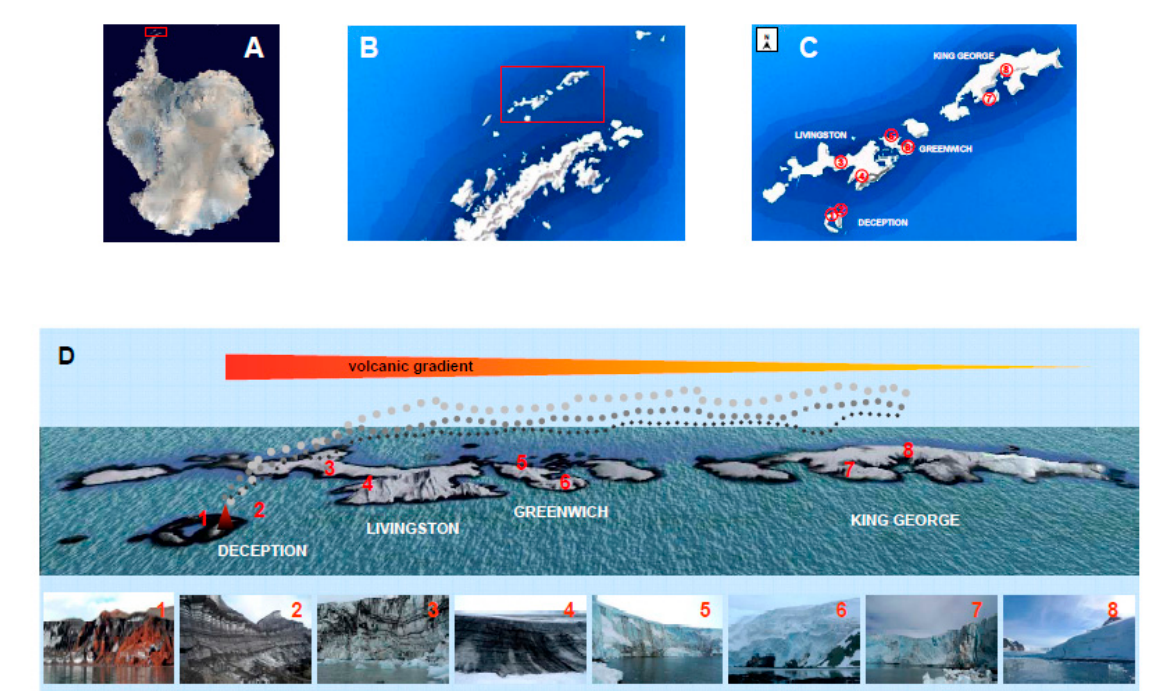
Figure 1. Location of sampling sites in South Shetland Islands, Antarctica. Satellite photographs of Antarctic continent ( A ) and Antarctic Peninsula ( B ) with South Shetland Islands boxed (ESA copyright-CC BY-SA IGO3.0; https://creativecommons.org/licenses/by-sa/3.0/igo/). ( C ) Map of Deception, Livingston, Greenwich, and King George Islands indicating the studied glaciers. ( D ) Volcanic gradient and setting of samples collected at glaciers: 1 Rojo; 2 Macaroni; 3 Johnson; 4 Hurd; 5 Quito; 6 Traub; 7 Ecology; 8 Machu Picchu. Ash and lava embedded in glacial ice can be observed along the gradient in the lower images.